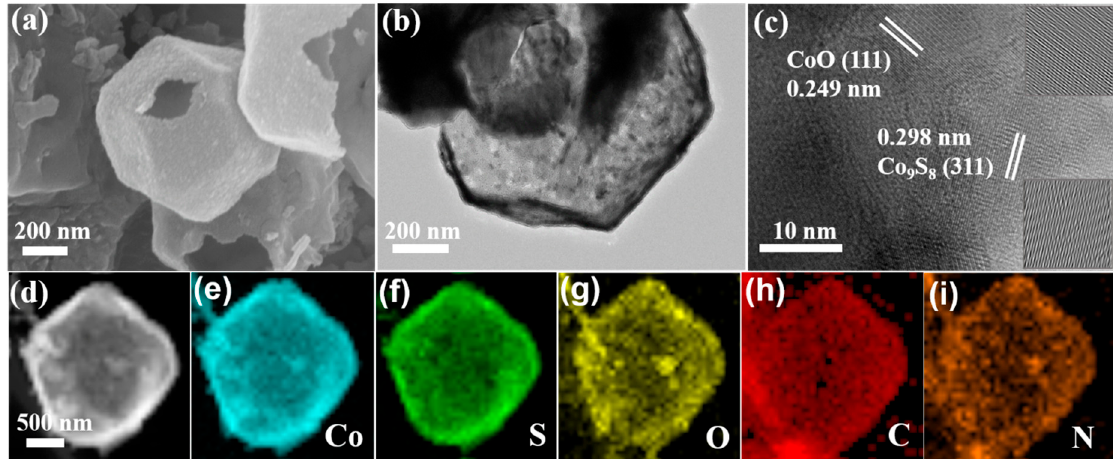
Figure 2. SEM, TEM, HRTEM images ( a – c ) and elemental distributions ( d – i ) of the ODR- Co 9 S 8 /CoO/NC heterostructure.